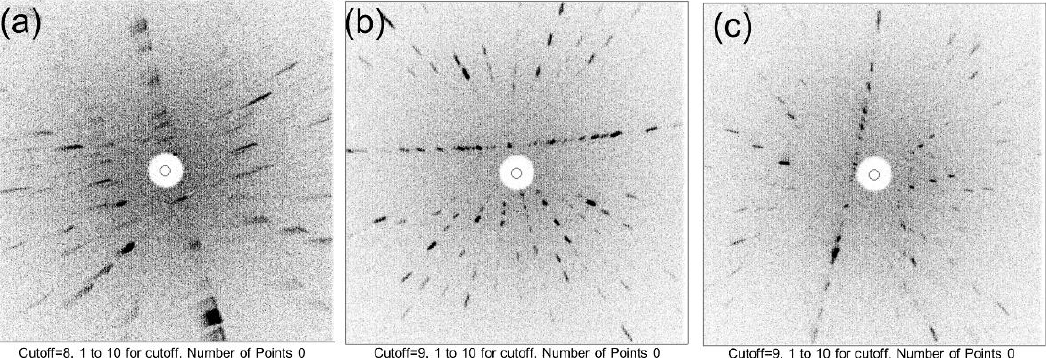
Figure 3. Laue patterns of bulk GeP single crystals grown by Bi flux method at a cooling rate of ( a ) 7 – 10 °C/h, ( b ) 4 – 6 °C/h and ( c ) 1 – 3 °C/h.